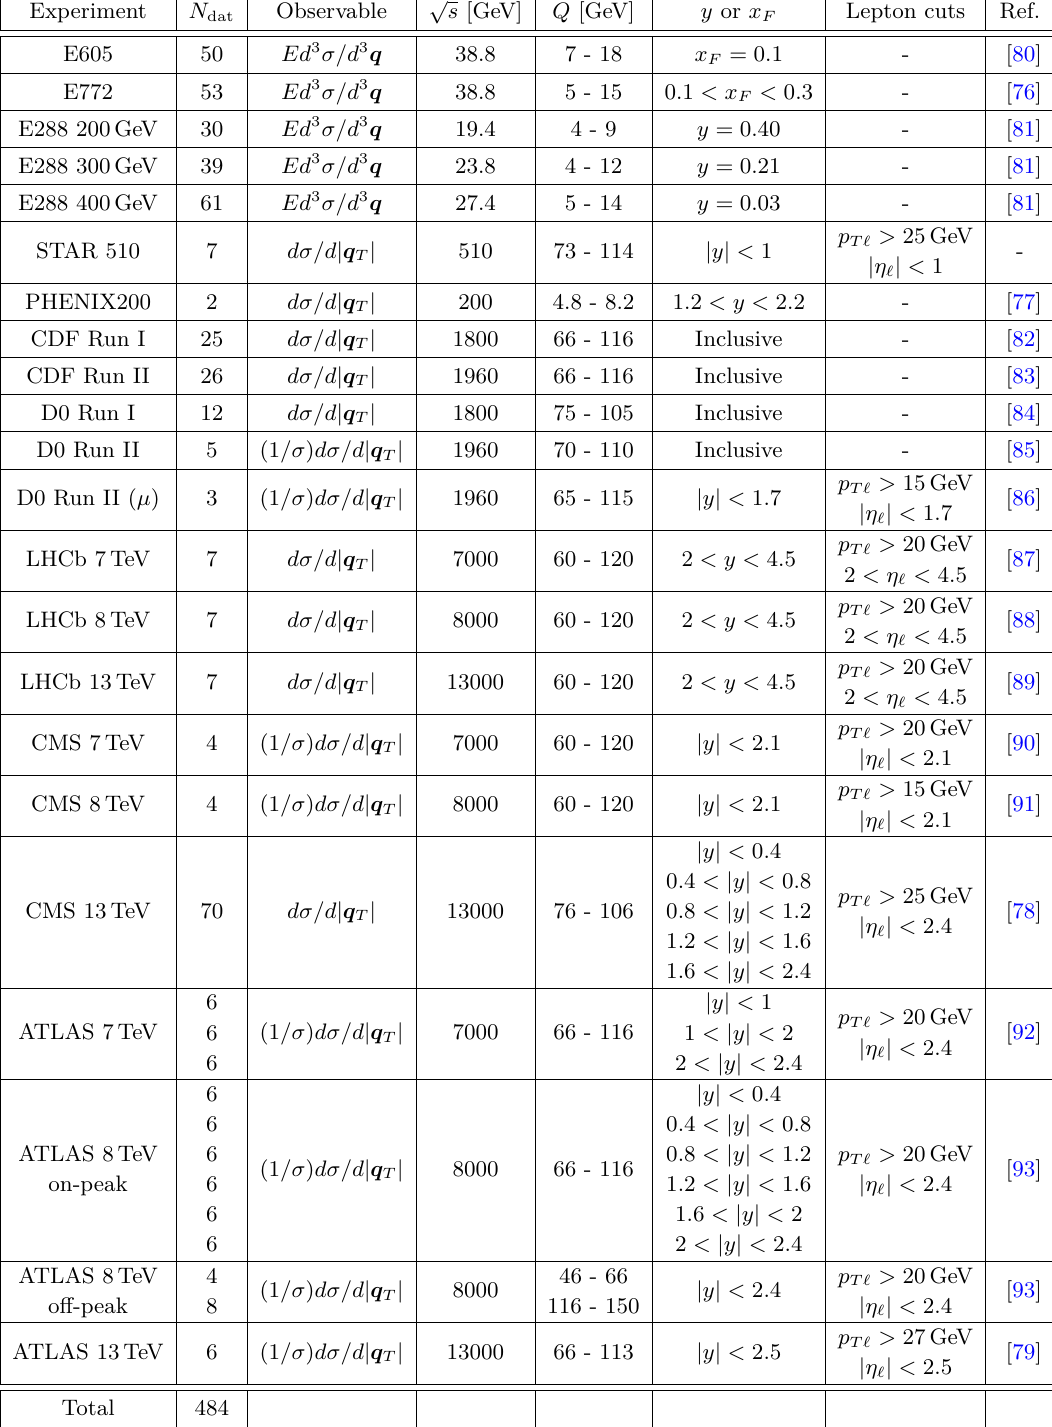
Table 2 . Breakdown of the DY datasets considered in this analysis. For each dataset, the table includes information on: the number of data points ( N mass Q , the angular variable (either y or x the published reference (when available). The total number of DY data points amounts to